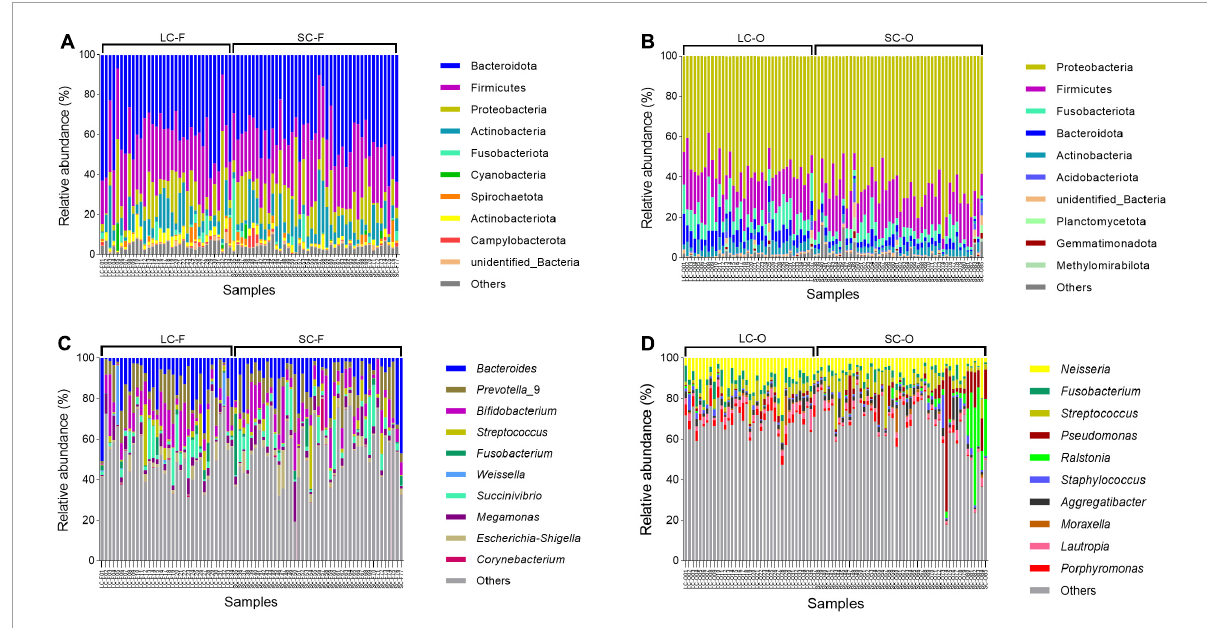
FIGURE4 Relative abundance of the top 10 bacterial phylum and genera in the fecal (A,C) and oral samples (B,D)